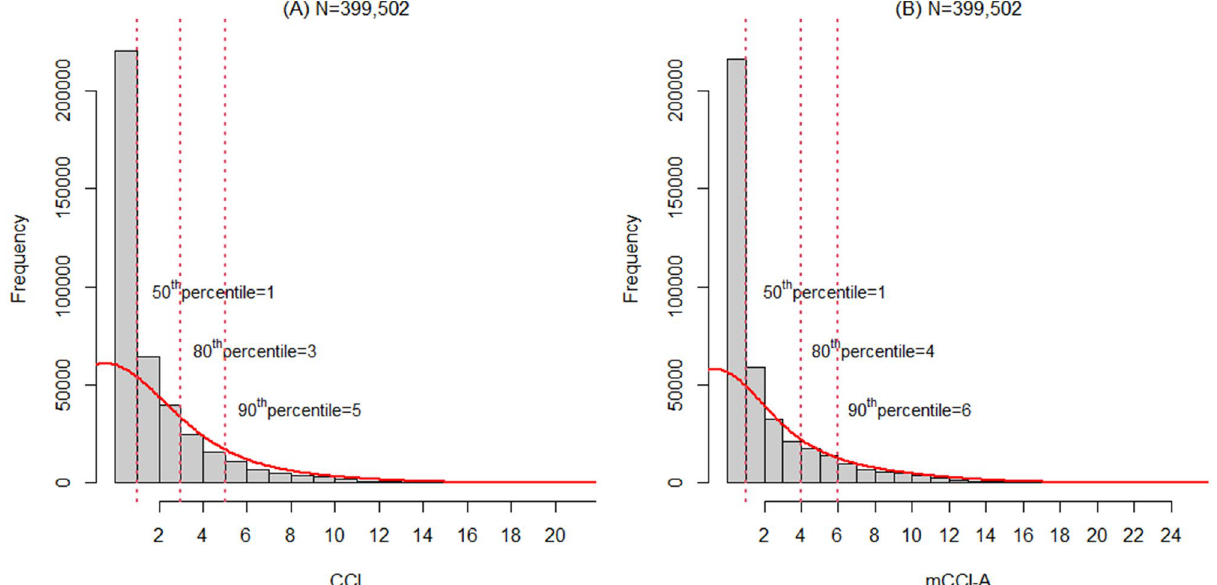
Figure 2. Distribution of the CCI and mCCI-A scores in the development cohort. ( A ) Distribution of the CCI scores (n = 399,502); ( B ) Distribution of the mCCI-A scores (n = 399,502). The y-axis shows the number of subjects. The solid line represents a density curve calculated by approximation to identify the overall pattern and deviation. The vertical dotted lines (red) represent the 50th, 80th, and 90th percentile values. CCI, Charlson Comorbidity Index; mCCI-A, modified version of the Charlson Comorbidity index for Asian